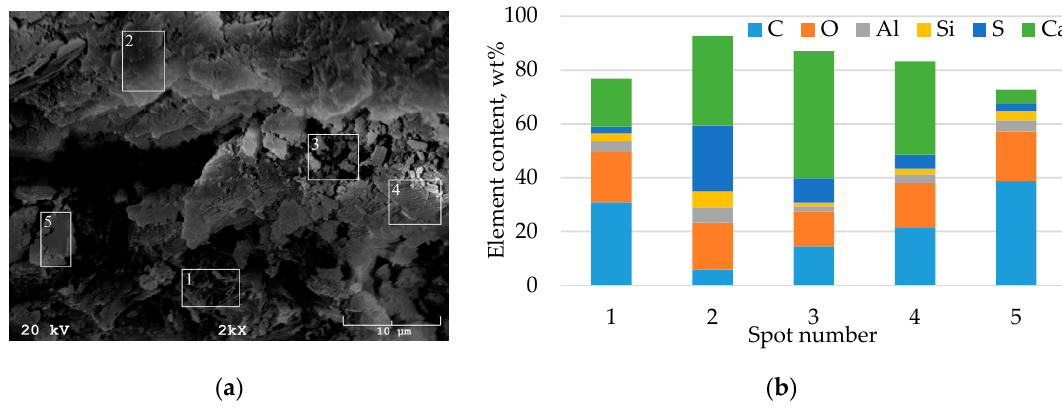
Figure 5. Energy Dispersive Spectroscopy (EDX) analysis of GCP-PG binder. ( a ) point positions analyzed by EDX, ( b ) element content in analyzed region.